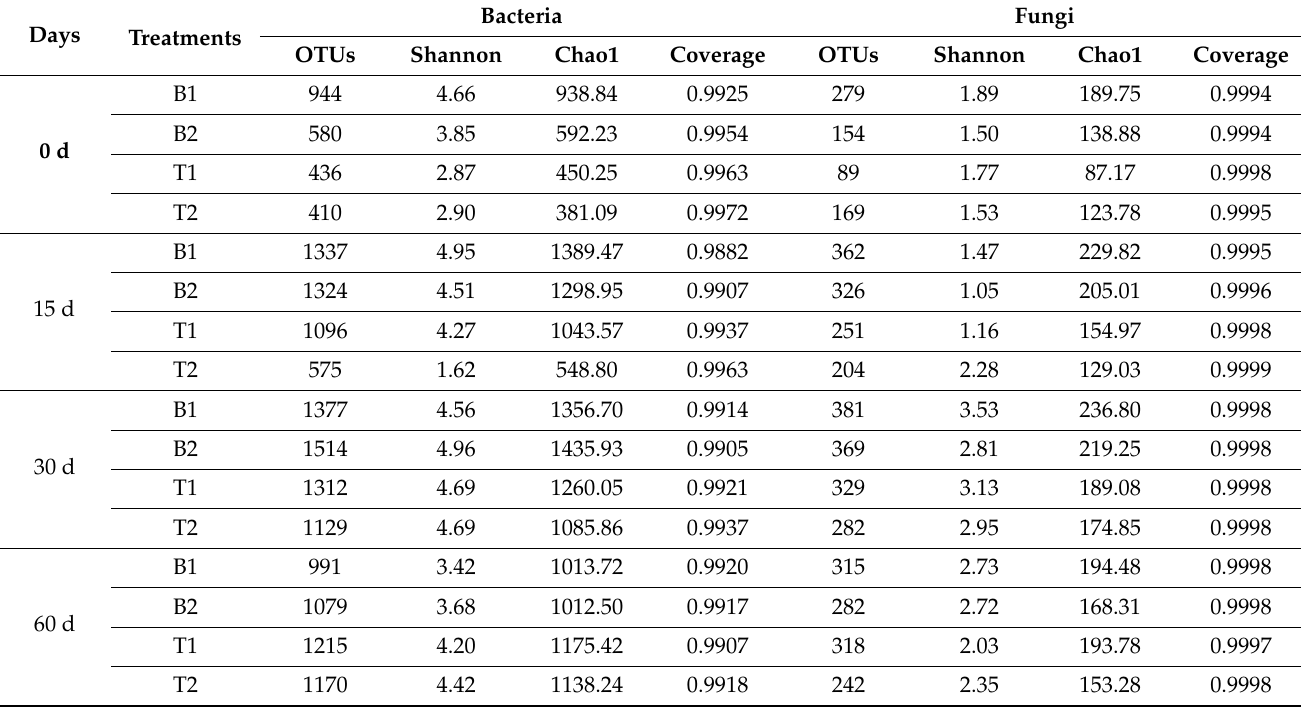
Table 5. Richness and Diversity of Microbial